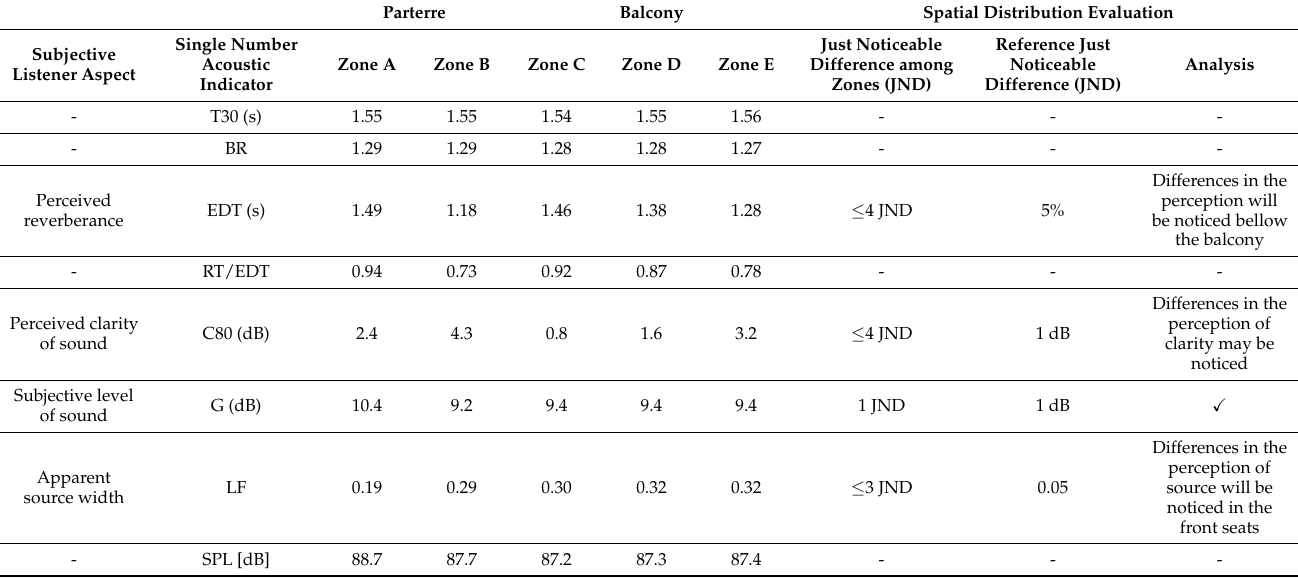
Table 12. Spatial distribution of acoustic indicators and JND values for configuration